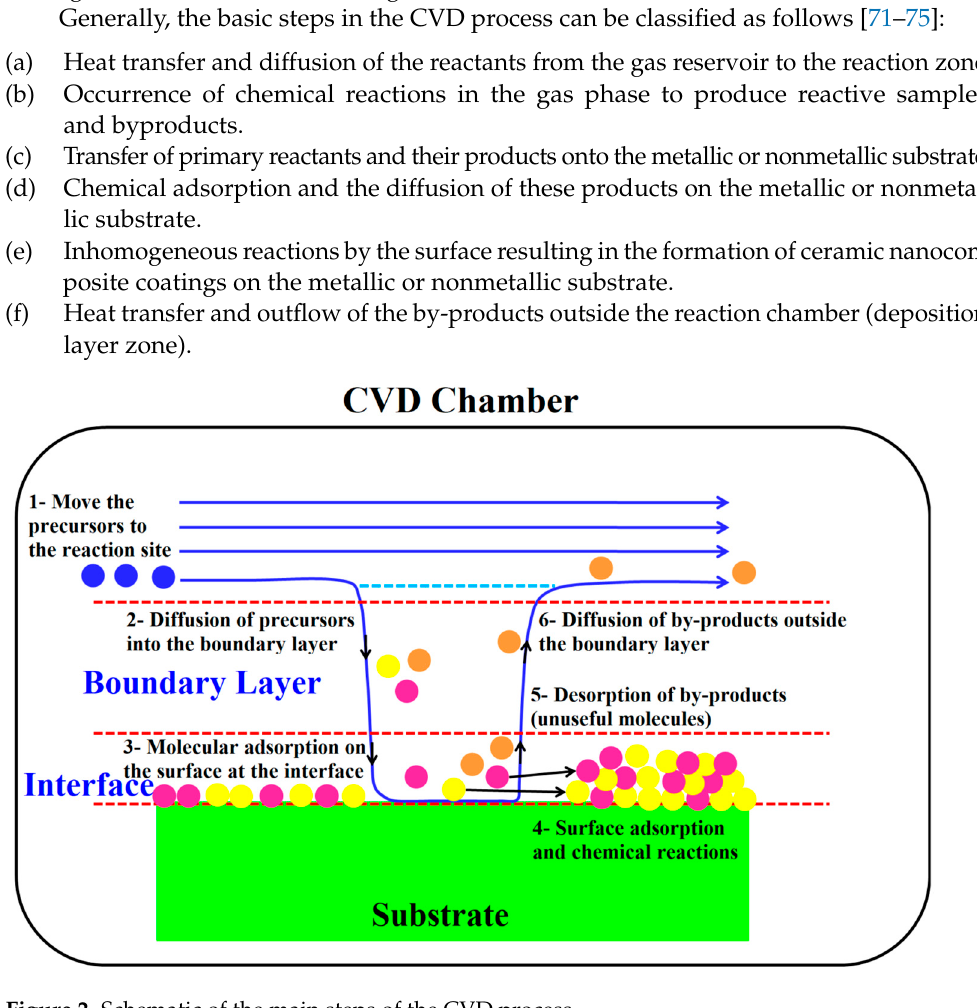
Figure 2. Schematic of the main steps of the CVD process.